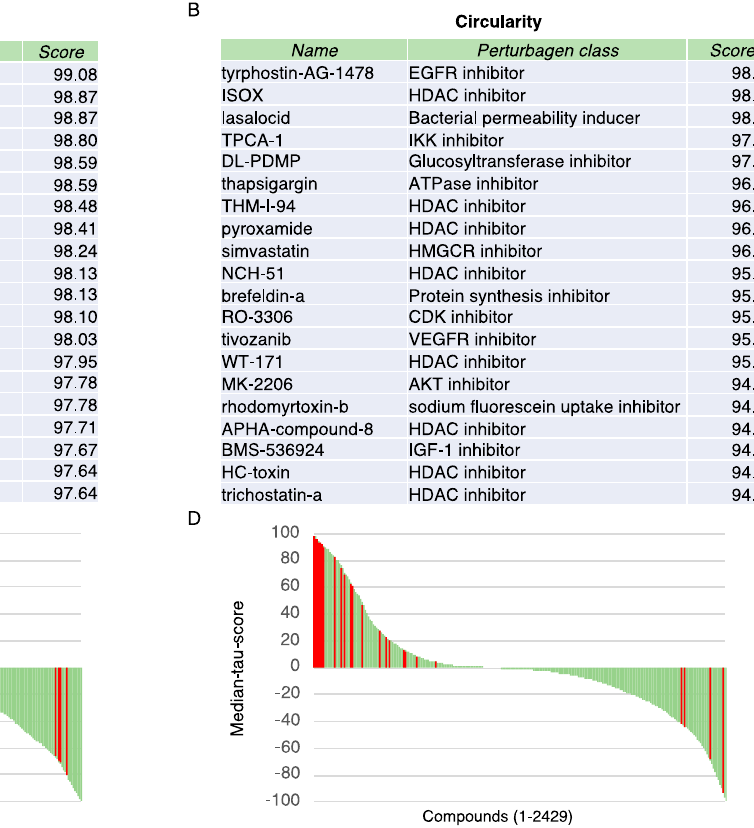
Figure 3. Connectivity Map analysis identifies HDAC inhibitors. ( A , B ) Top twenty compounds, the gene expression signature of which displays a connectivity score above ≥ 90 with the gene expression signatures for AUC and area-2h ( A ) and Circularity ( B ). ( C , D ) Connectivity score distribution for the gene expression signatures for AUC and area-2h ( C ) and Circularity ( D ) and all the 2429 perturbagen signatures (green bars). The results are expressed as median tau scores, with a scale-free measure ranging from -100 to 100. HDAC inhibitors are indicated with red bars.